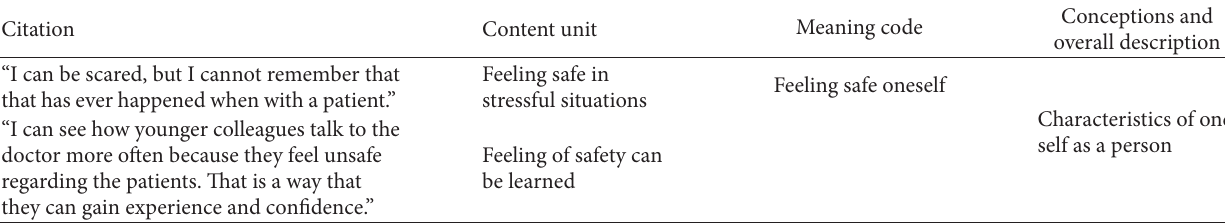
Table 1: Illustration of the steps in data analyses.